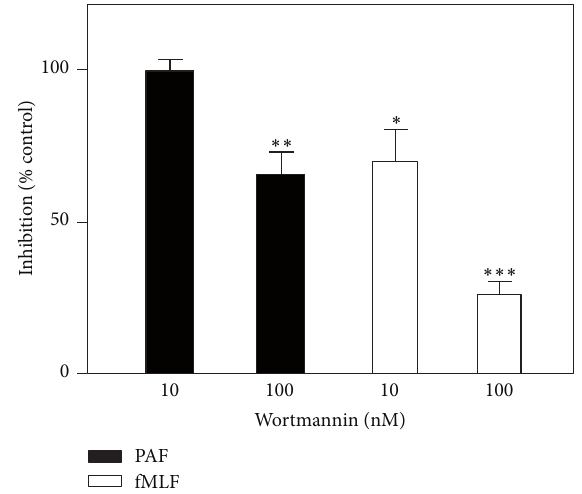
Figure 8: Effect of the PI3-kinase inhibitor wortmannin on the PAF and fMLF-induced release of superoxide anions. Human neutrophils (10 5 cells) were incubated without (control), or with wortmannin (10nM or 100nM) for 10min at 37 ∘ C. The cells were then stimulated with PAF (100nM) or fMLF (100nM), and the release of superoxidewas recorded continuously. Effects of wort- mannin expressed in % of superoxide production (peak values compared) obtained without any additive (mean ± SEM; 𝑛 = 3